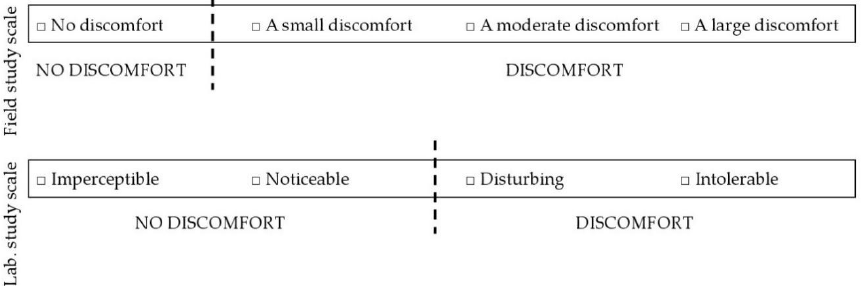
Figure 2. Binary transformation (no discomfort–discomfort) of the subjective glare scales used in the field and laboratory studies.